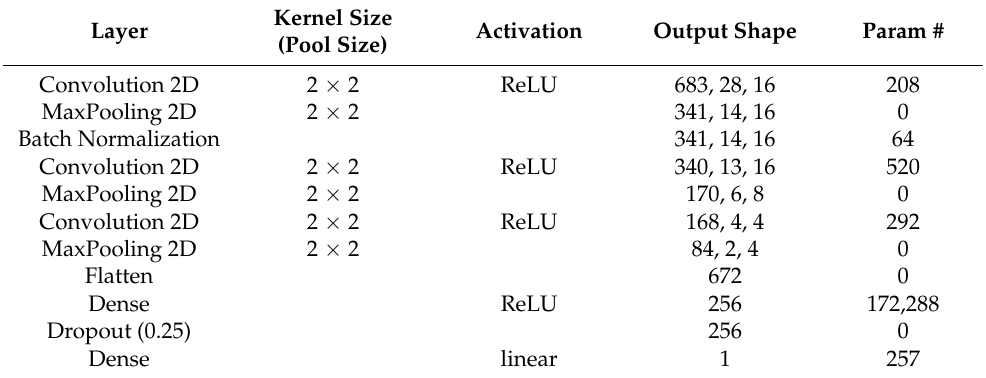
Table 2. Parameters of the image-based baseline model.